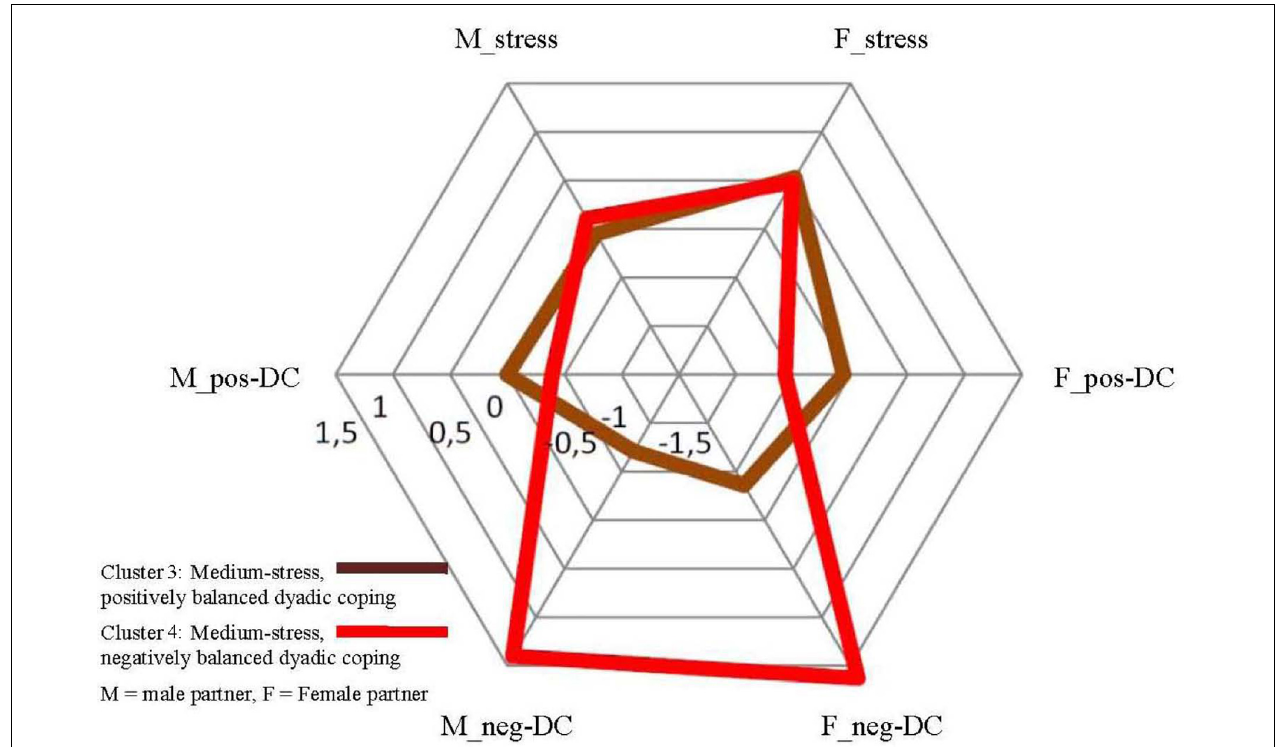
FIGURE 2 | Medium-stress couples: Cluster centers of Cluster 3 and 4,